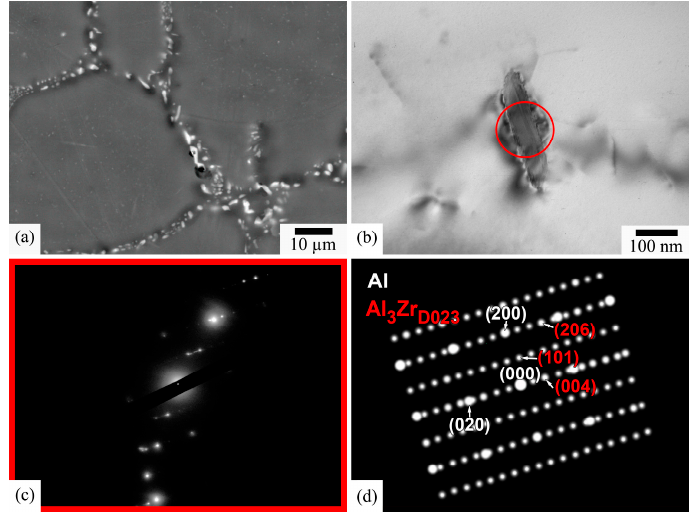
Figure 6. TEM micrographs of Al-1% Fe-0.25% Si-0.3% Zr annealed at S600 with incoherent D0 23 Al 3 Zr particles: ( a ) SEM; ( b ) TEM; ( с ) diffraction; ( d ) schematic diffraction pattern with indexes.